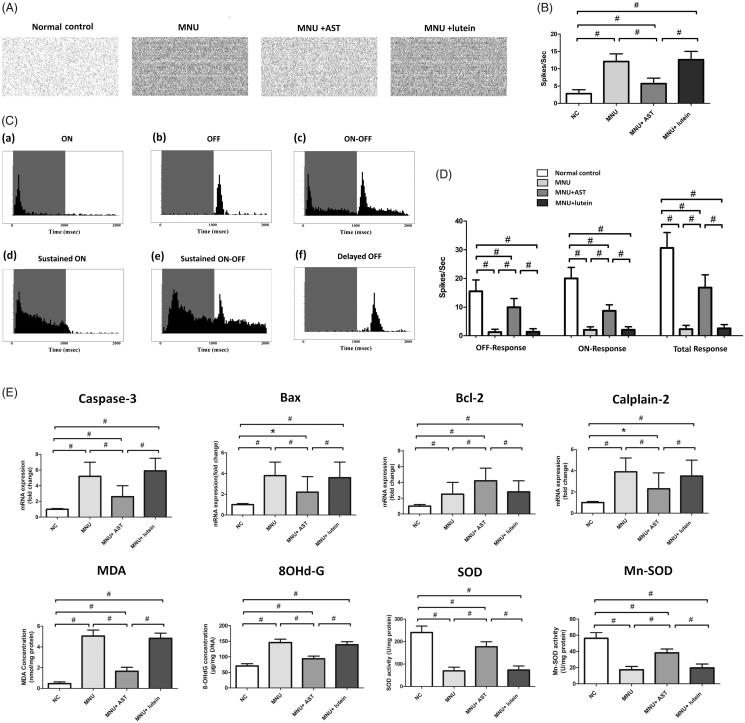
(A) Spontaneous firing spikes of RGCs were detected by MEA system. (B) The spontaneous firing rate in the MNU was significantly higher compared with the normal controls. The spontaneous firing rate in the MNU + AST group was significantly lower compared with the MNU group. (C) Six categories of RGCs were isolated according to their PSTHs. (D) The total firing rate decreased significantly in the MNU group than that in the normal controls. The total firing rate was significantly higher in the MNU + AST group than that in the MNU group. Moreover, the OFF pathway was more efficiently preserved than the ON pathway. (E) The mRNA levels of Caspase-3, Calpain-2, and Bax in the MNU + AST group were significantly down-regulated compared with the MNU group. The mRNA level of Bcl-2 in the MNU + AST group was significantly up-regulated than that in the MNU group. Moreover, the retinal levels of MDA and 8-OHdG were significantly lower in the MNU + AST group compared with the MNU + lutein group. The retinal levels of SOD and Mn-SOD were significantly higher in the MNU + AST group compared with the MNU + lutein group. (ANOVA analysis followed by Bonferroni’s post hoc analysis was performed, *p < .05, #p < .01, for differences between groups; n = 10).